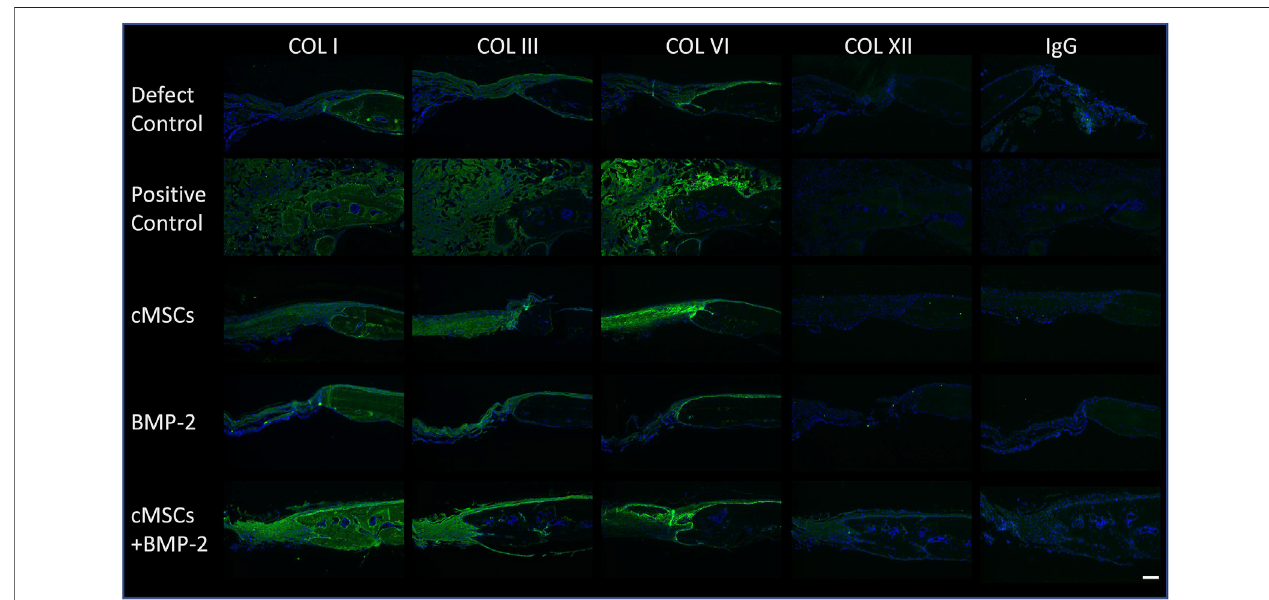
FIGURE 5 | Immuno fl uorescence of Collagens Type I, III, VI, and XII in murine calvarial defects. Immuno fl uorescence was performed to determine the presence of Collagen Type I, III, VI, and XII within calvarial defects. Bound primary antibodies were detected with a goat anti-rabbit Alexa fl our488 (green) secondary antibody. Slides wereprocessedwith4 ′ ,6-diamidino-2-phenylindole(DAPI)toidentifynuclei.Negativecontrolsections(IgG)areprovidedforreference.Excitationrangewas495 nmand emission 519 nm (bar (cid:2) 100 μ M). Representative images are provided for all treatment groups. Collagen Type I, III, and VI were detected in all treatment groups. Collagen I staining was diffusely present, whereas Collagen III was limited tothe fi brous tissue bridging the defect and the leading edge of bone healing. Collagen VI was detectedinalltreatmentgroups,andco-localizedwithCollagenIII.CollagenXIIwasnotdetectibleinanyofthetreatmentgroupswiththeexceptionofthecMSC+BMP- 2 treatment group, where it was weakly present and co-localized with Collagens III and VI. Collectively, Collagen I, III, VI, and XII staining was the greatest in the cMSC + BMP-2 treatment group, providing a potential mechanism for the treatment effect of this